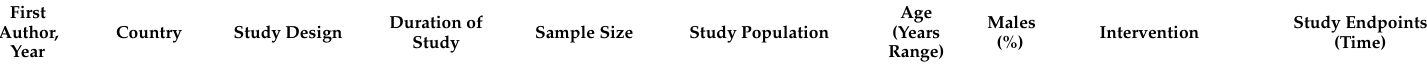
Table 2. Summary of the descriptive characteristics of the RCTs included in the